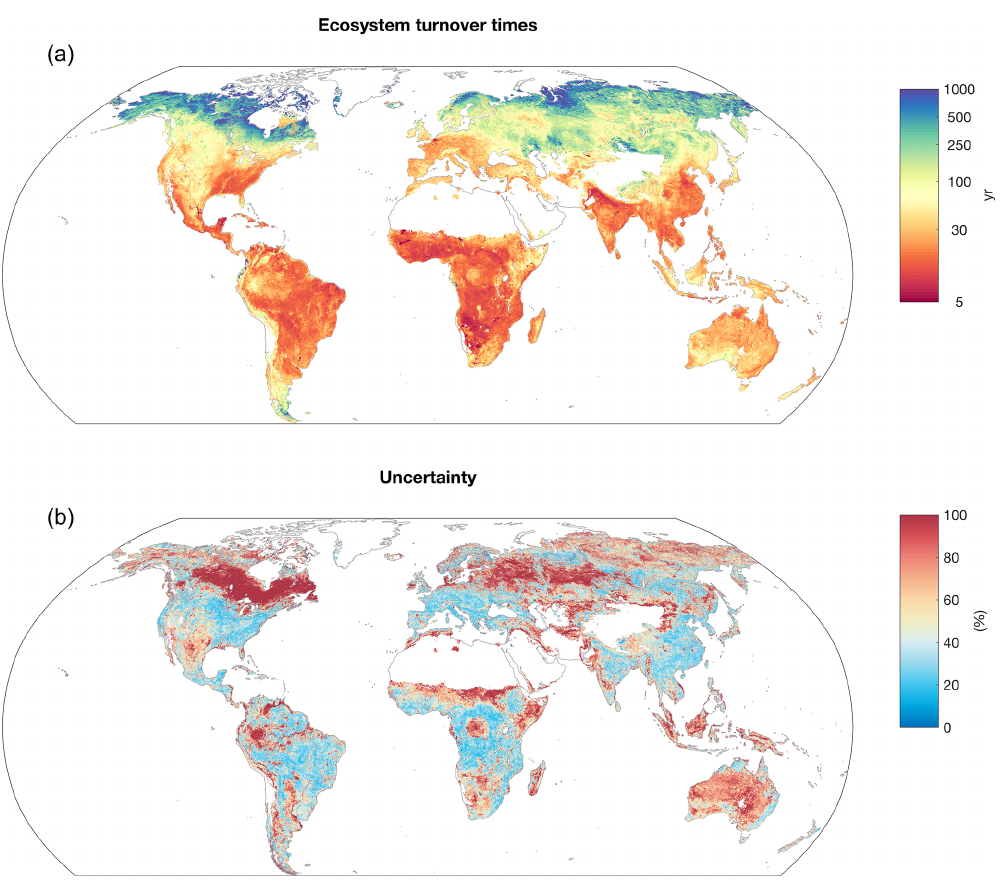
Figure 5. Spatial distribution of ecosystem turnover times. Panel (a) shows spatial distribution of turnover times, and panel (b) shows the relative uncertainty (calculated as a ratio of interquartile range/mean). The range of color bar in (a) approximately spans between the 1st and the 99th percentiles of the data, and the one in (b) spans between the 1st and 90th percentiles.